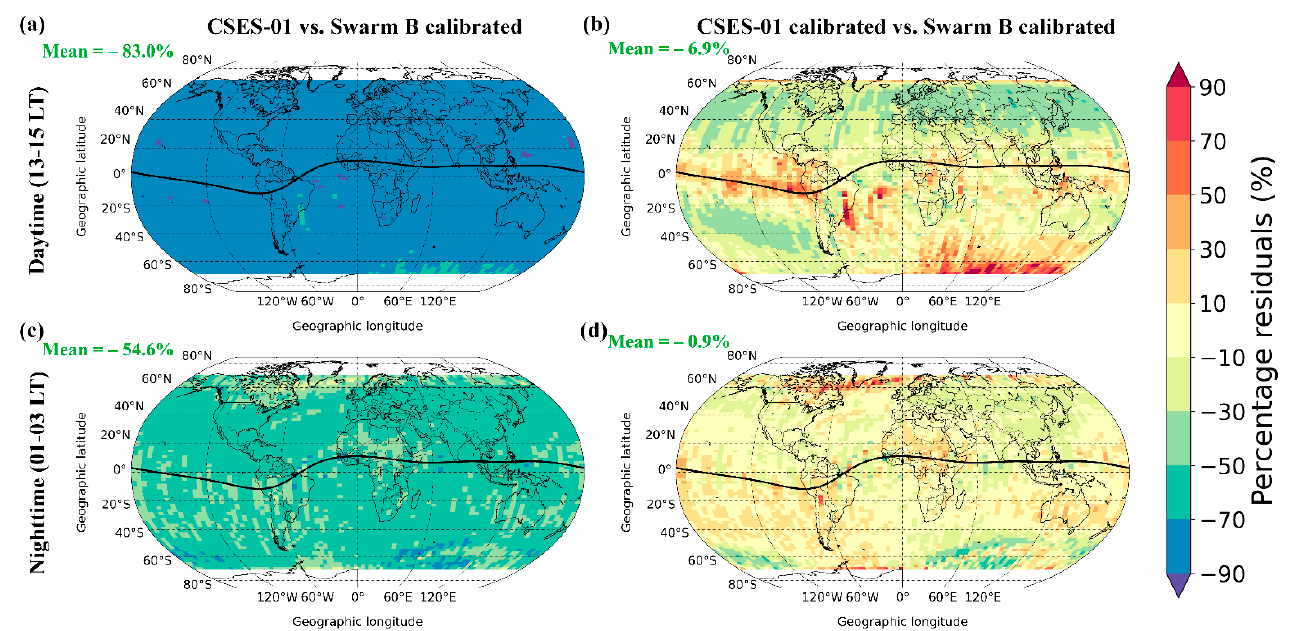
Figure 8. Geographical maps of percentage relative residuals between mean values of CSES-01 N e and Swarm B LP N e calibrated with FP. Panels ( a , c ) are for CSES-01 original data; Panels ( b , d ) are for CSES-01 data calibrated through Swarm B data. Panels ( a , b ) refer to the daytime sector (13:00 − 15:00 LT); Panels ( c , d ) refer to the nighttime sector (01:00 − 03:00 LT). In green, the mean of the percentage relative residuals calculated for the whole map is reported. Data encompass the period from 1 January 2019 to 30 September 2021. The thick black curve in each plot represents the geomagnetic equator.